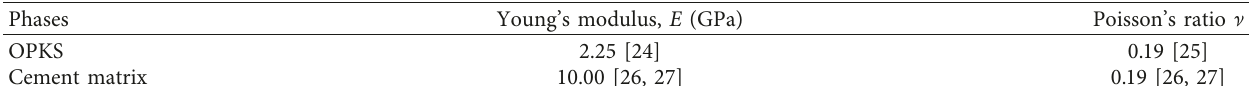
Table 2: Young’s modulus and Poisson’s ratio of OPKS and cement matrix.